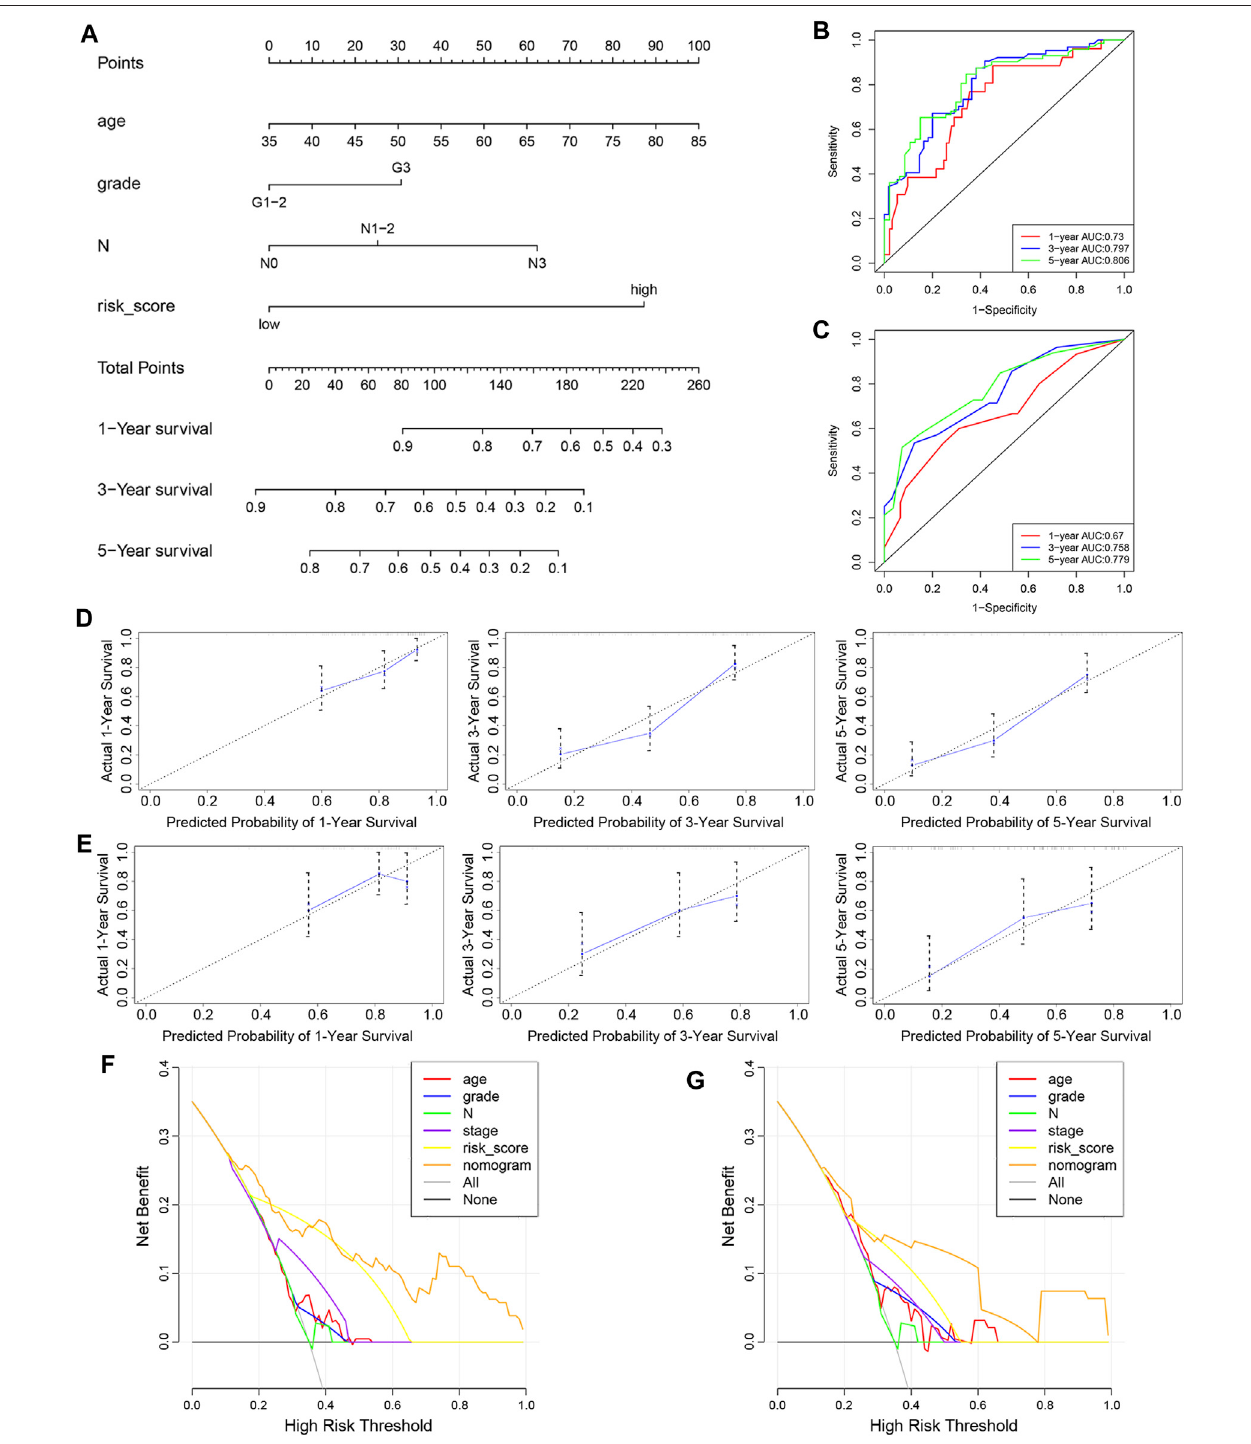
FIGURE 5 | Construction and evaluation of nomogram. (A) Nomogram based on the risk score of the 10-FRG signature and clinical information of patients in the GSE53624 dataset. (B,C) Time-dependent ROCcurvesofthenomogramin theGSE53624 and GSE53622 datasets. (D,E) Calibrationcurvesofthe nomogram for OS predictionat1,3and5 yearsforpatientsintheGSE53624andGSE53622datasets. (F,G) DCAcurvesofthenomogramandotherindependentpredictivefactorsinthe GSE53624 and GSE53622 datasets.